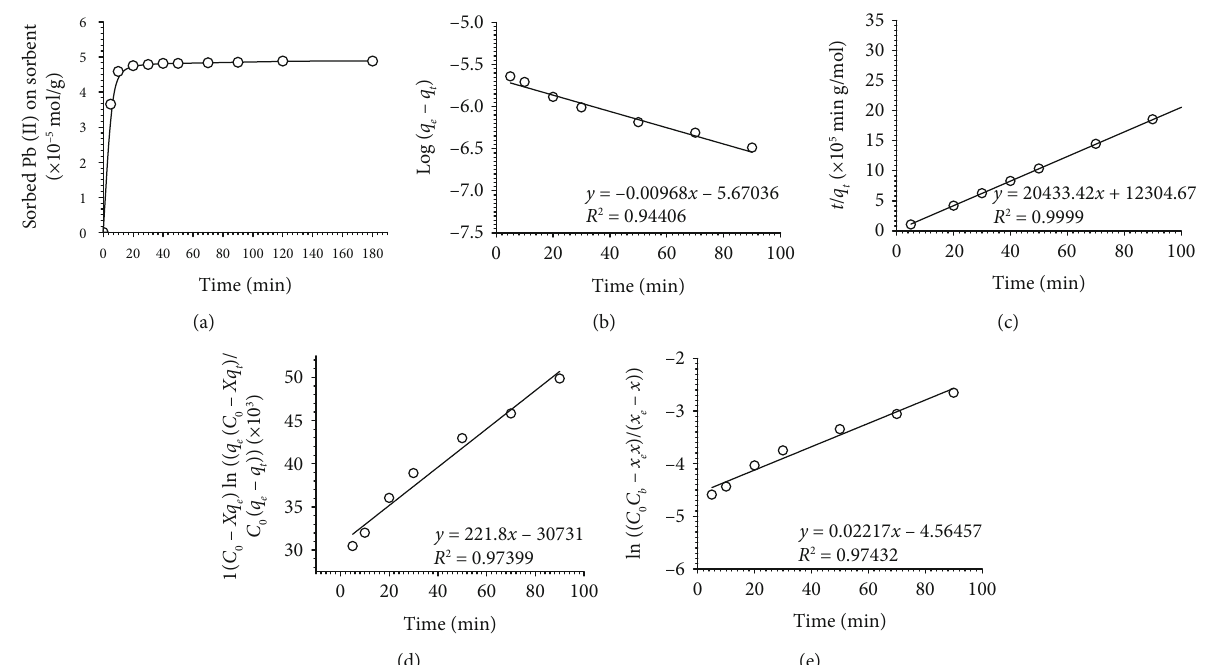
Figure 7: (a) Pro fi le of Pb(II) uptake onto MHDHA as a function of time and adsorption kinetics plot of 25mg/L (0.12 mmol/L) Pb(II) onto 20mg MHDHA by (b) Lagergren, (c) Ho, (d) proposed Santosa, and (e) proposed RBS kinetics model. Table 5: Kinetics parameters of Pb(II) adsorption onto MHDHA. Kinetics